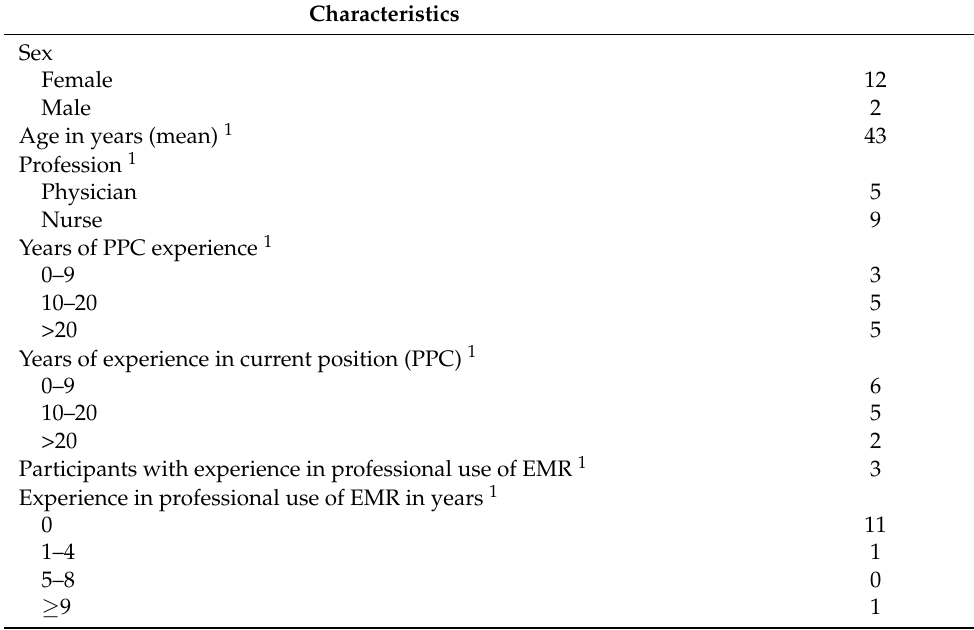
Table 2. Overview of the participants’